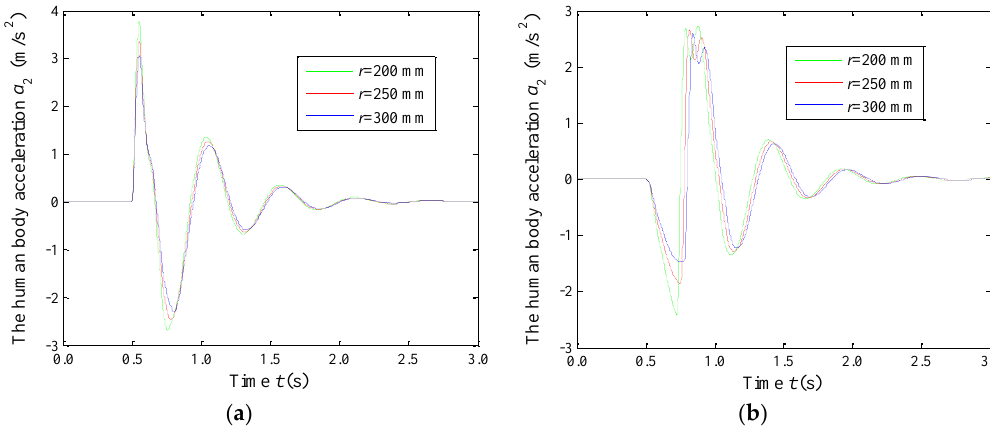
Figure 11. A comparison of the time histories of the human body acceleration a 2 at different values of r for the wheelchair: ( a ) going up the step; ( b ) going down the step.